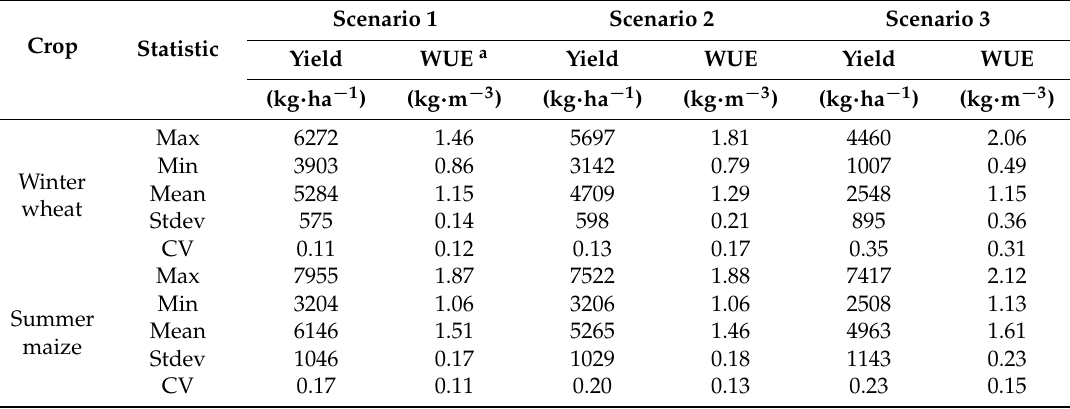
Table 8. Grain yield and WUE of winter wheat and summer maize from 1969 to 2010 under different